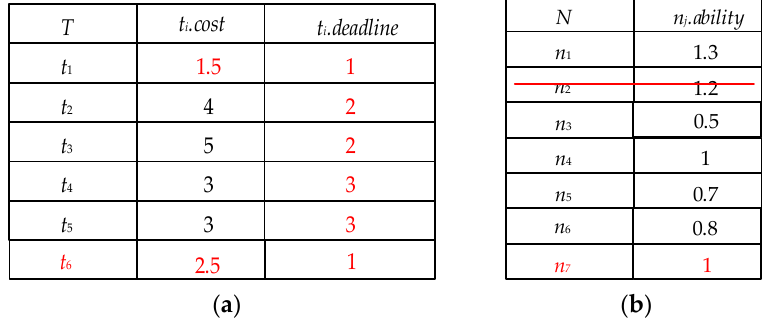
Figure 2. An example of task scheduling at time l 1 . ( a ) List of tasks at time l 1 ; ( b ) list of volunteer nodes at time l 1 ; ( c ) task allocation process at time l 1 .